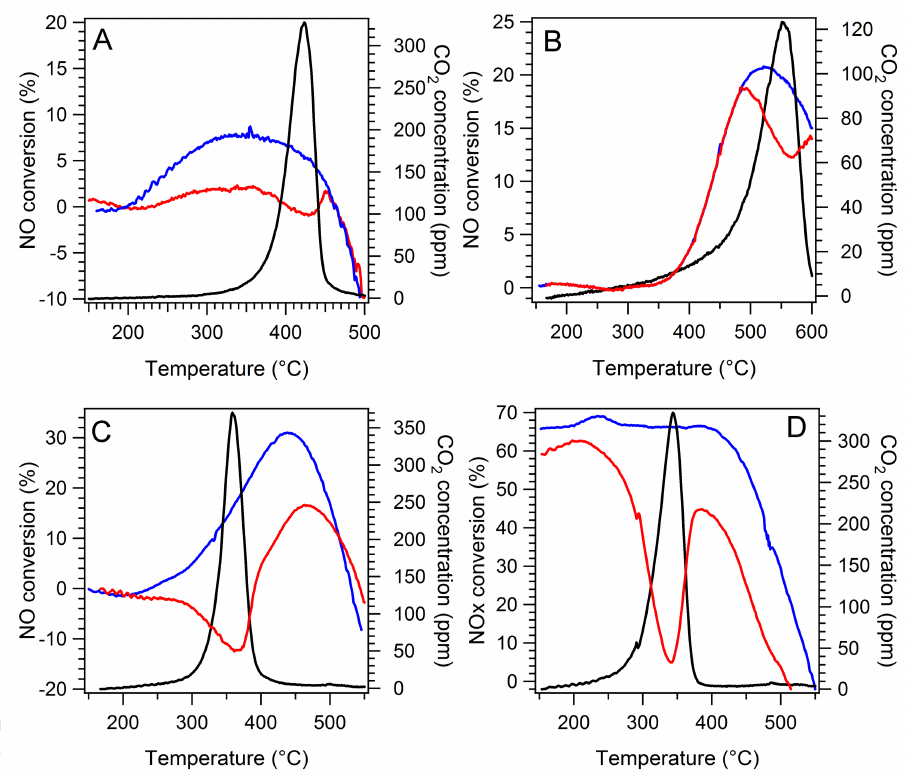
Figure 7. SCR runs on single components of the catalysts. Blue lines represent SCR of the bare samples, red lines represent SCR activity of the samples in tight contact with soot, black lines represent CO 2 production during soot combustion. ( A ) FeVO 4 ; ( B ) TWS; ( C ) Ce 0.75 Zr 0.25 O 2 standard SCR; ( D ) Ce 0.75 Zr 0.25 O 2 fast